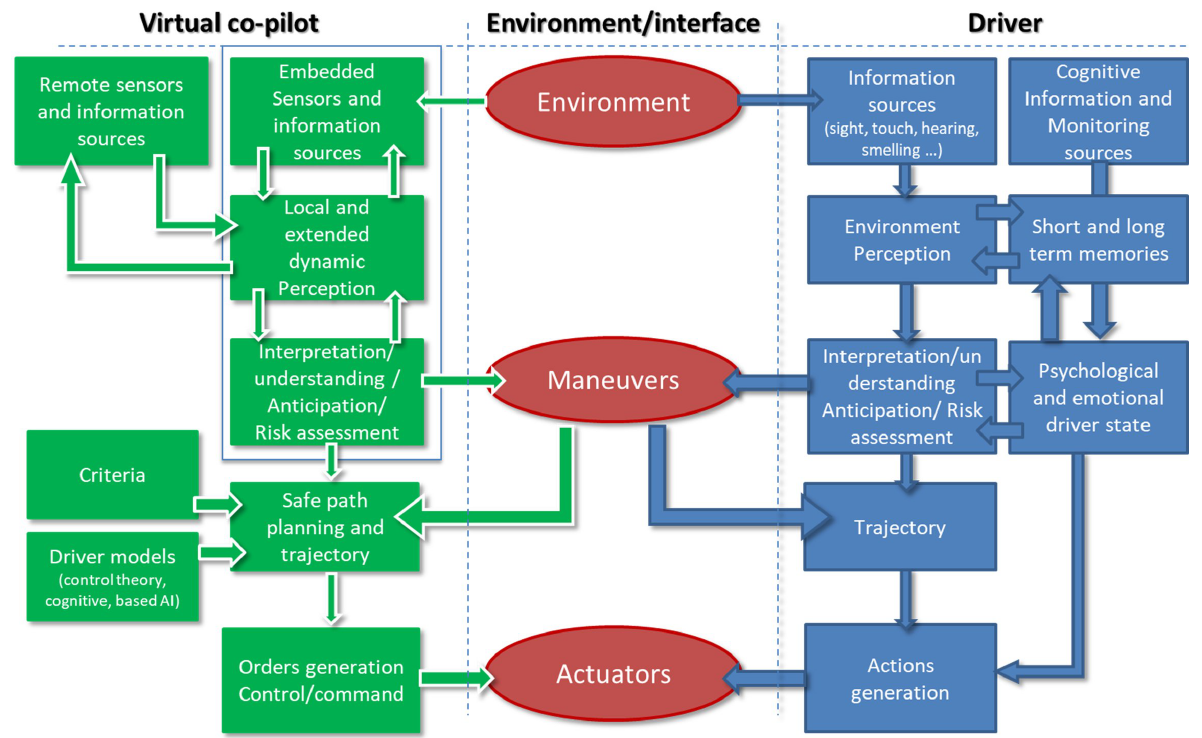
Figure 2. Similarity between human and machine driving task